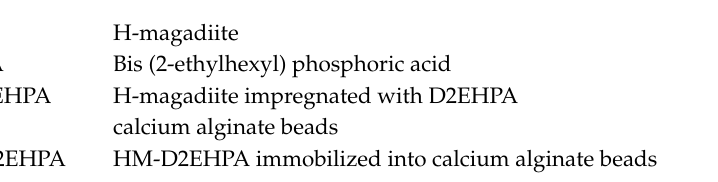
Figure S1: Metal species as a function of pH (Pb(II), Ni(II)), Figure S2: Points of zero charge of different sorbents. (a) HM-D2EHPA; (b) CA; (c) CAM-D2EHPA, Table S1: Langmuir, Freundlich, and Sips constants of CA material, Figure S3: Sorption and desorption efficiency of lead (a) and nickel (b) by CAM-D2EHPA material. ( T : 20 ◦ C; sorbent dosage, SD: 10 g L − 1 ; agitation speed: 180 rpm; contact time: 3 h; C 0 : 50 mg L − 1 ; C (HNO 3 ): 0.5 M; time of desorption: 30 min), Figure S4: Images of calcium alginate beads, and CAM-D2EHPA hybrid beads; a) before adsorption; b) after